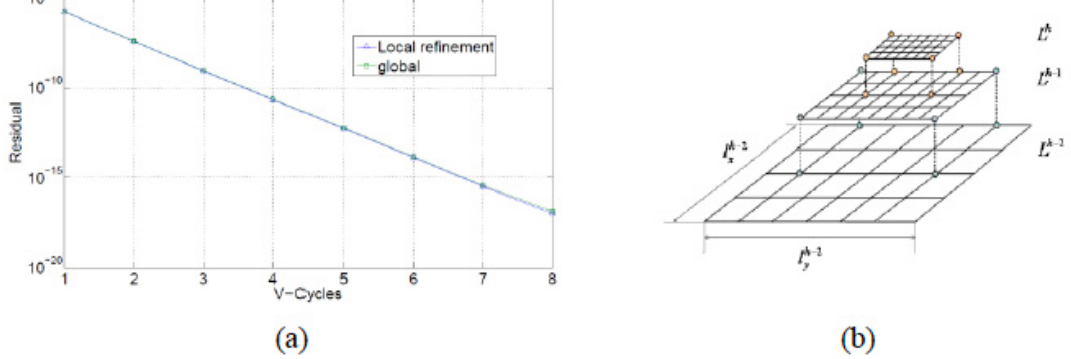
Figure 20. Residuals of the solution ( a ) for a unit flow disc heat transfer problem by means of a multigrid scheme ( b ). Taken with permission from [121].